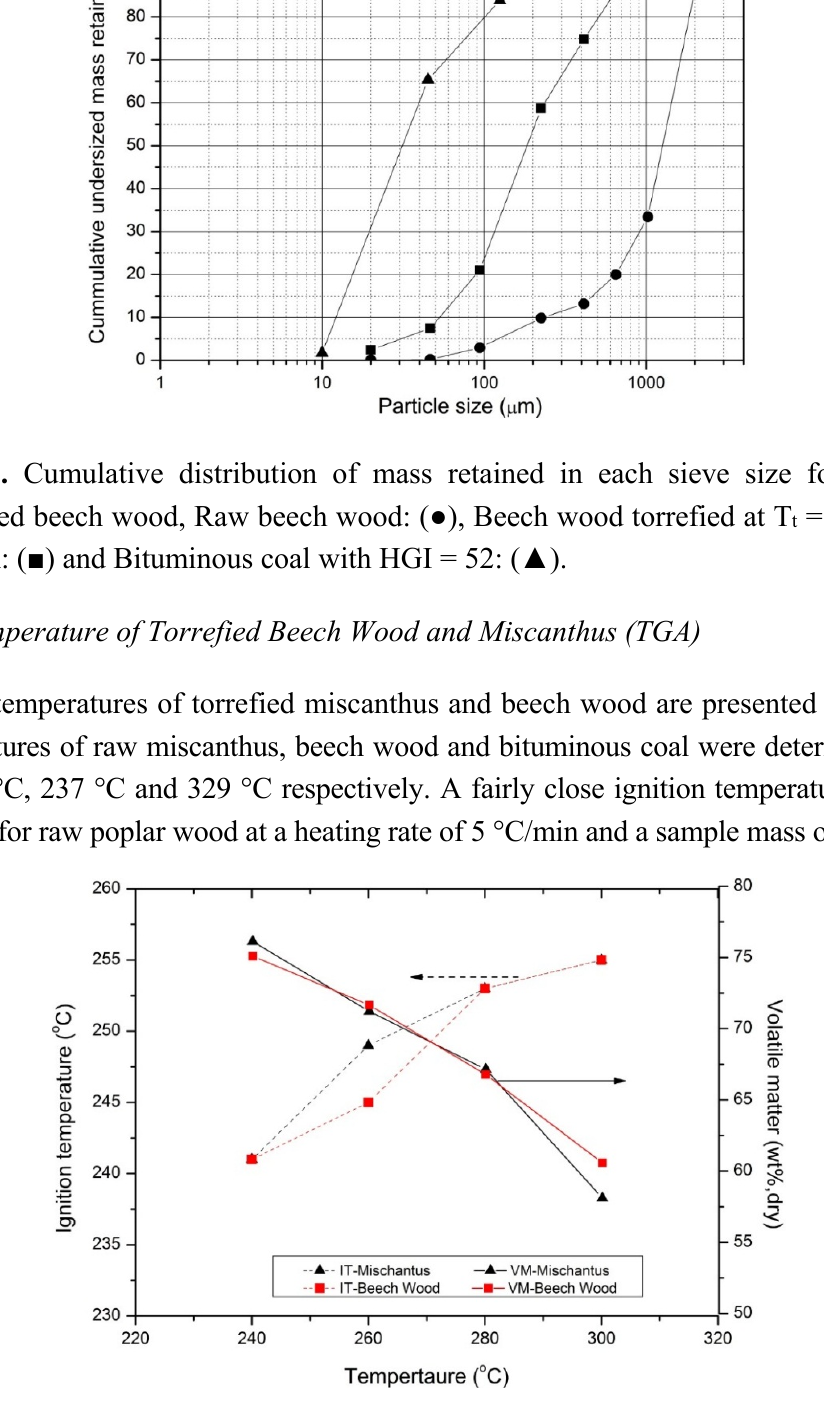
Figure 14. Ignition temperature of torrefied beech wood and miscanthus at a residence time of 30 min, IT (ignition temperature) and VM (volatile matter)